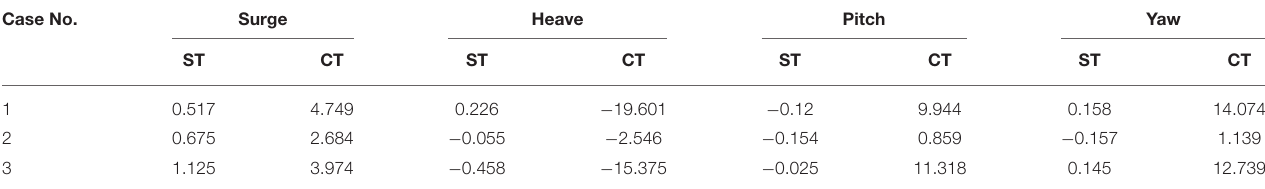
TABLE 6 | Variation of error of two methods